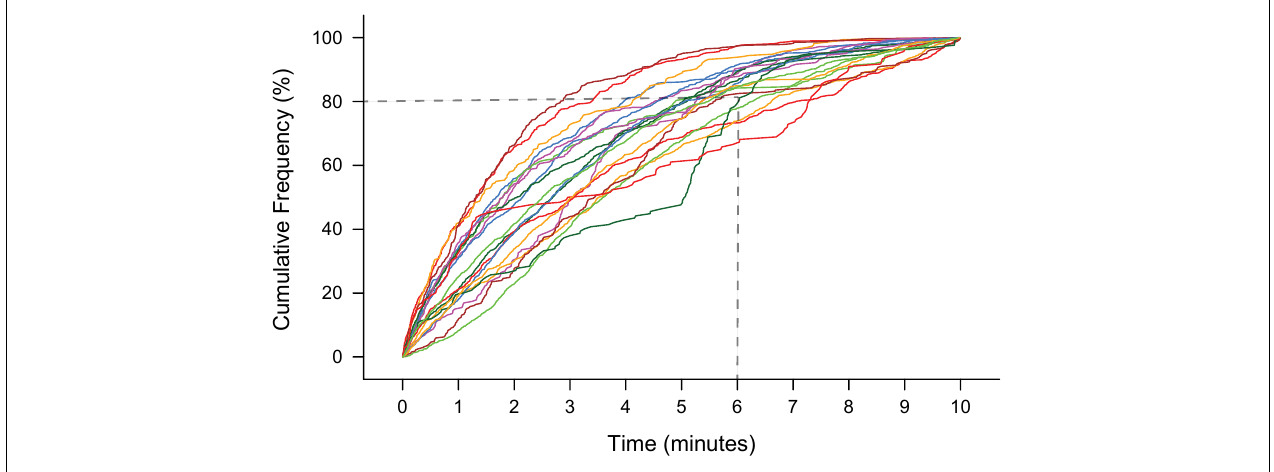
FIGURE 4 | The ultrasonic vocalization (USV) productions during 10 min of recording of 20 female Long-Evans rats elicited by an introduction to a male rat. Each line is the cumulative frequency of USVs for an individual rat. The majority (16/20) rats produced 80% of their total number of USVs within the first 6 min of recording. The total number of USVs produced ranged from 100 –